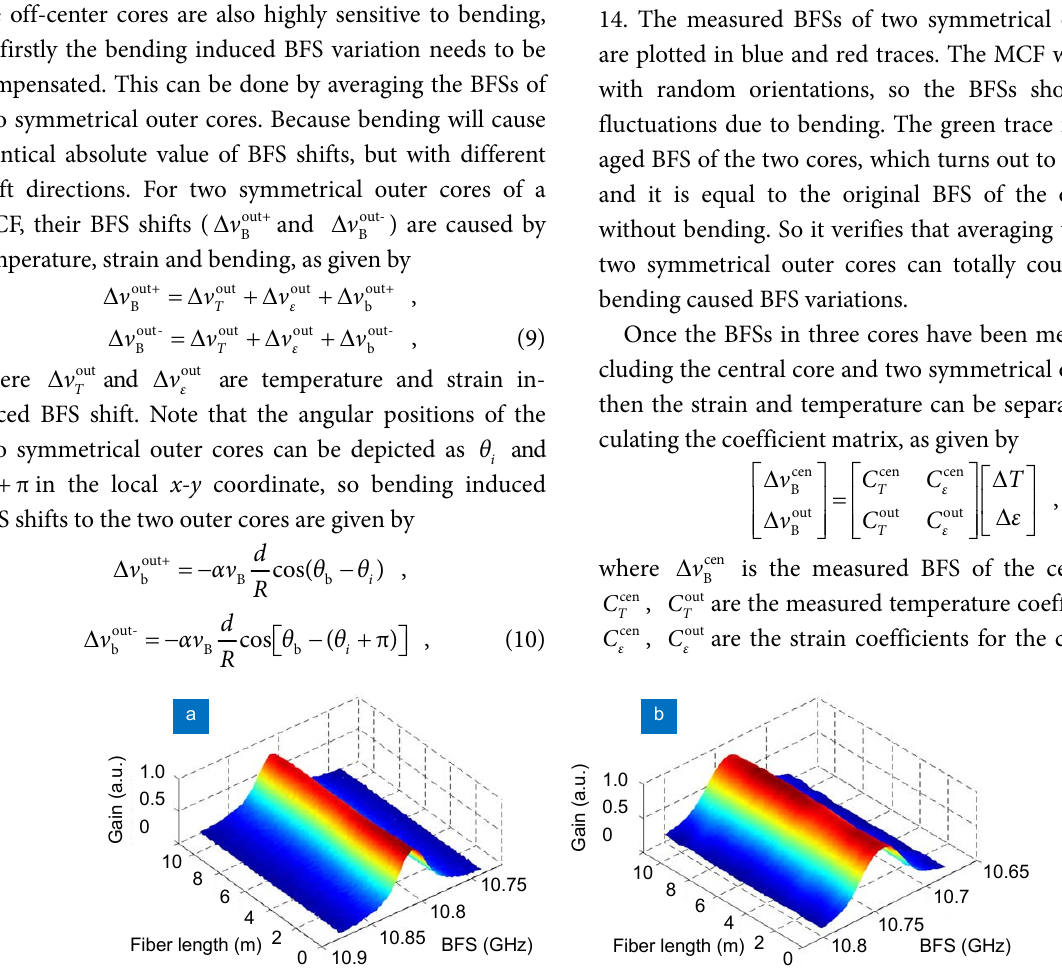
Fig. 13 | The measured BGS of a heterogeneous MCF. ( a ) The central core with peak at ~10.81 GHz. ( b ) The outer core with peak at ~10.74 GHz. Figure reproduced from ref. 56 , Optical Society of America.